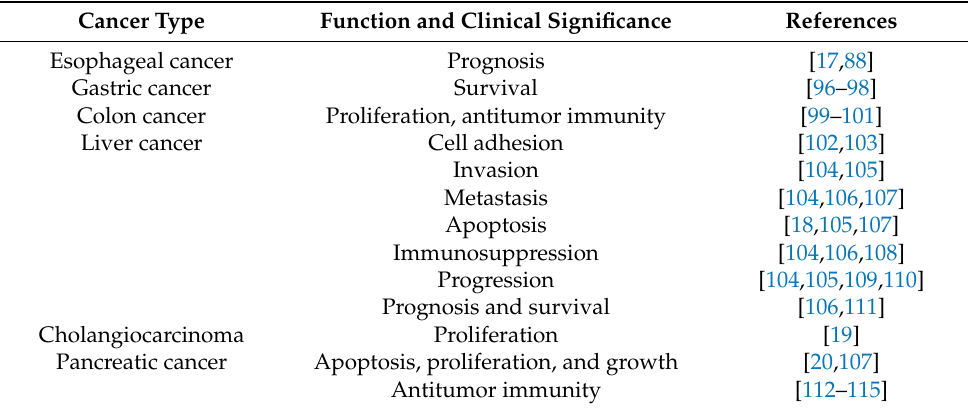
Table 1. Function of galectin-9 in gastroenterological cancers. Cancer